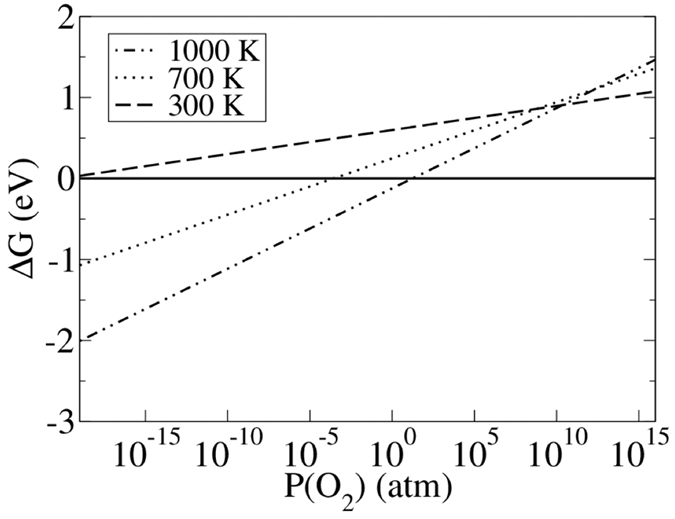
Nint3c-ZrO2/Nsub3c-ZrO2 stability phase diagram as a function of O2 partial pressure at 300 K, 700 K and 1000 K in terms of the reaction (2), i.e. NintZrO2 --> NsubZrO2 + 1/2 O2.The solid line represents ΔG = 0 eV.